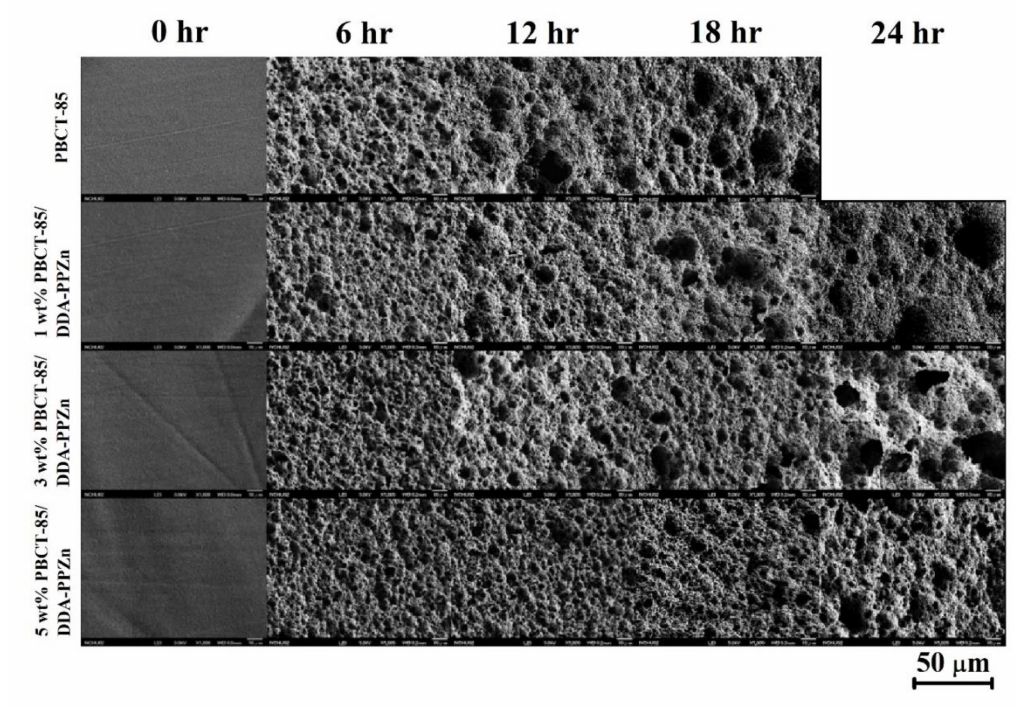
Figure 9. FESEM images of the enzymatically degraded PBCT-85 / DDA-PPZn